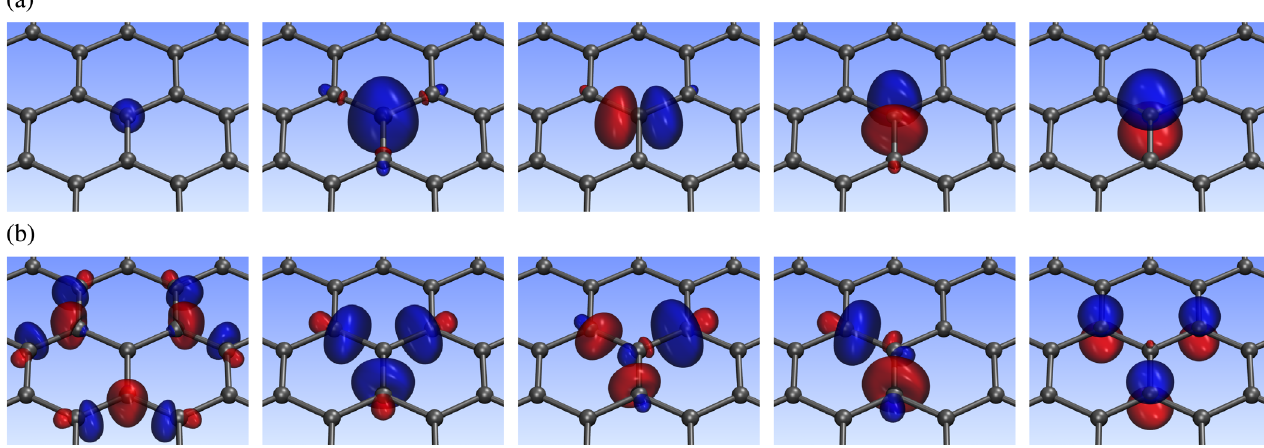
FIG. 7. Isosurface plots of the IAO fragment orbitals (a) and corresponding DMET bath orbitals (b) of a single-carbon fragment in graphene. An isovalue of (cid:3) 0 . 09 is used for all plots.